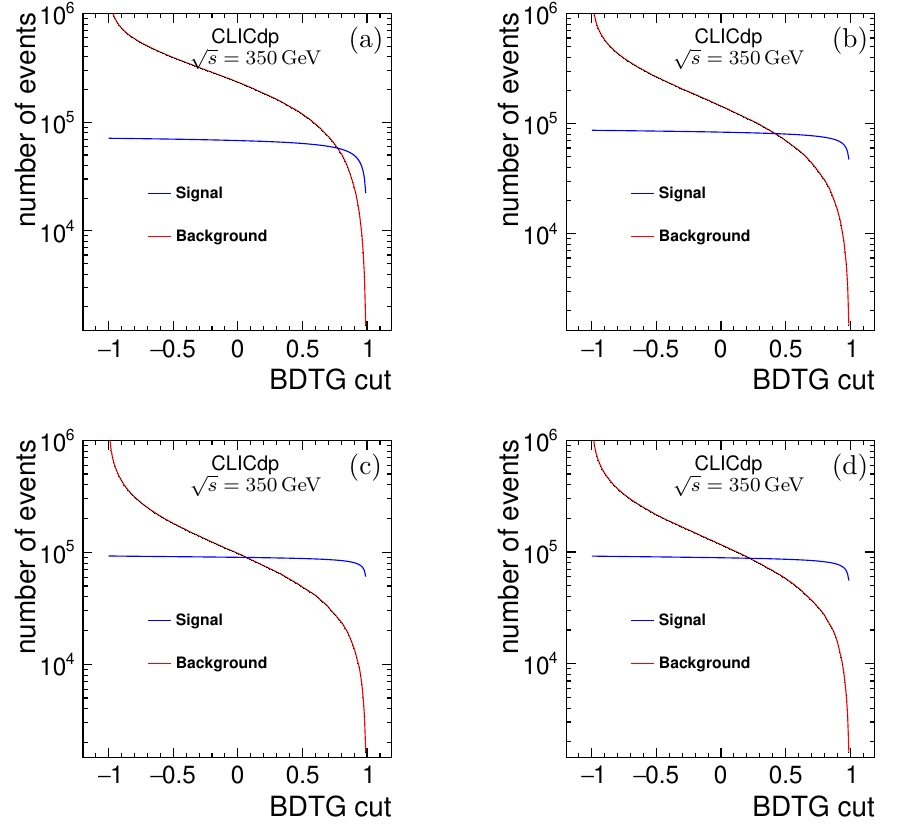
Figure 4 . Distributions of the number of events left after introducing the requirement on BDTG √ response for signal samples at s = 350 GeV with π 0 mass of 35 GeV/c 2 and four different lifetimes: v (a) 1 ps, (b) 10 ps, (c) 100 ps, (d) 300 ps, compared to combined